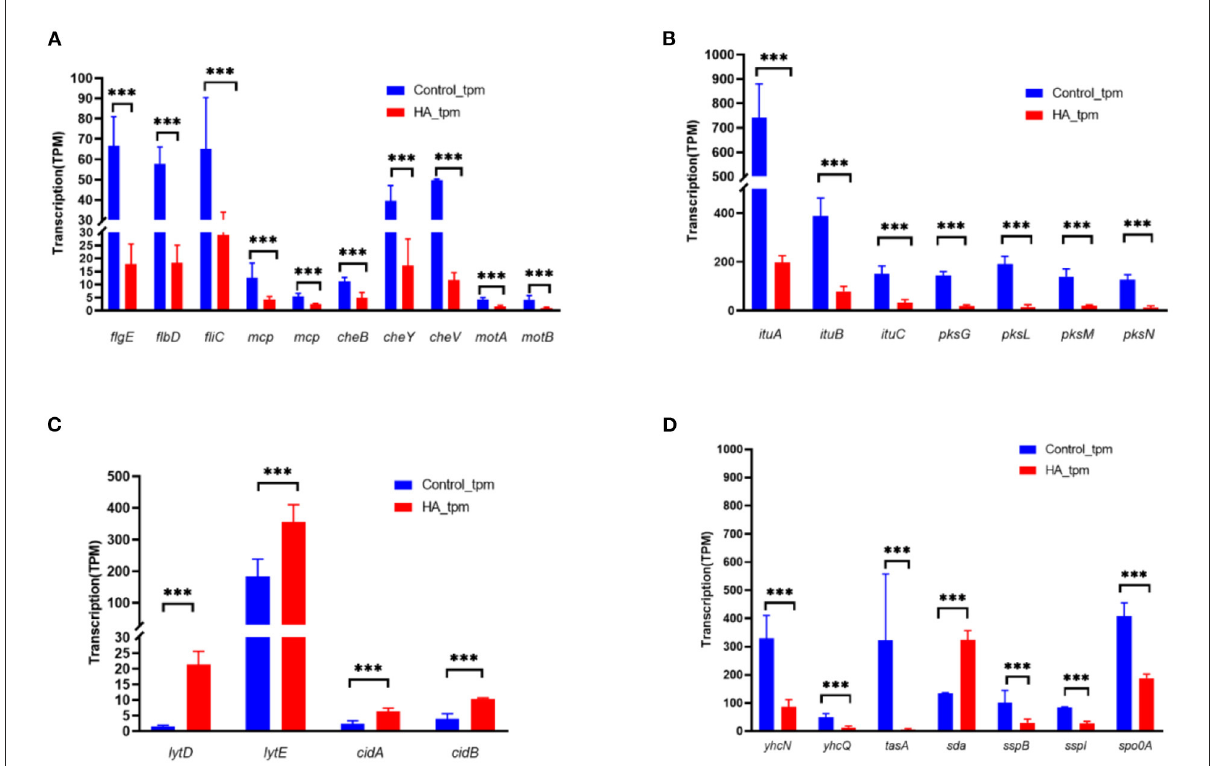
FIGURE5 Changes in the abundance of genes modulating multicellular behavior in B. velezensis V4 upon exposure to HA. (A) Expression of motility and chemotaxis-related genes in B. velezensis V4 upon exposure to hydroxylamine. (B) Expression of polyketide synthetase (PKS) and non-ribosomal peptide synthetase (NRPS) genes in B. velezensis V4 upon exposure to hydroxylamine. (C) Expression of autolysis-related genes in B. velezensis V4 upon exposure to hydroxylamine. (D) Expression of sporulation-related genes in B. velezensis V4 upon exposure to hydroxylamine. RNA-seq data were normalized to TPM. Error bars indicate standard error based on three replicates. p -values were calculated using a negative binomial distribution-based test, and false discovery rate ( p -adjust) was calculated using the Benjamini/Hochberg method. At each time point, *** represents a significant change in transcript abundance (FDR <